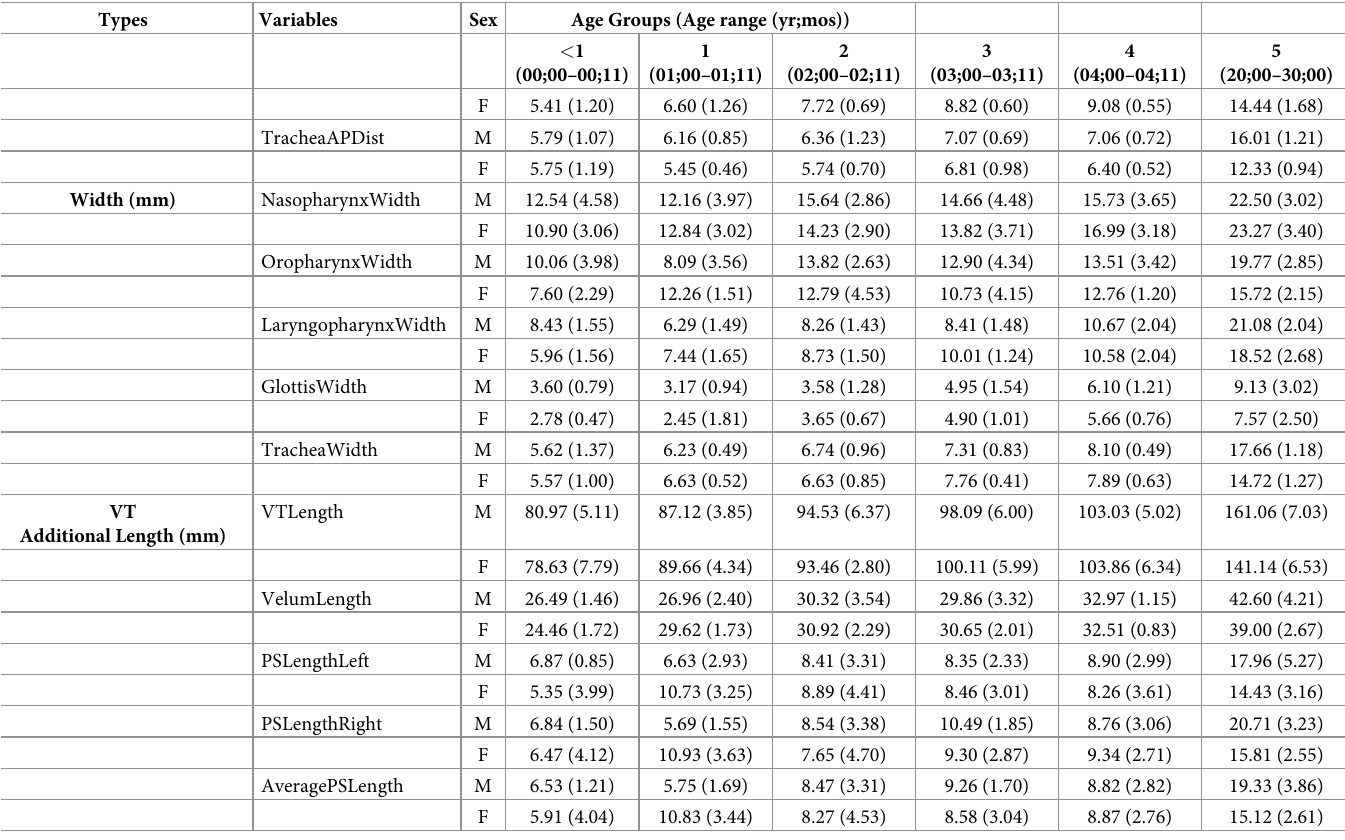
Age-specific mean (standard deviation) of the different measurement types for each of the variables examined with M/F denoting the average Male/Female measurements. Age groups as specified in Table